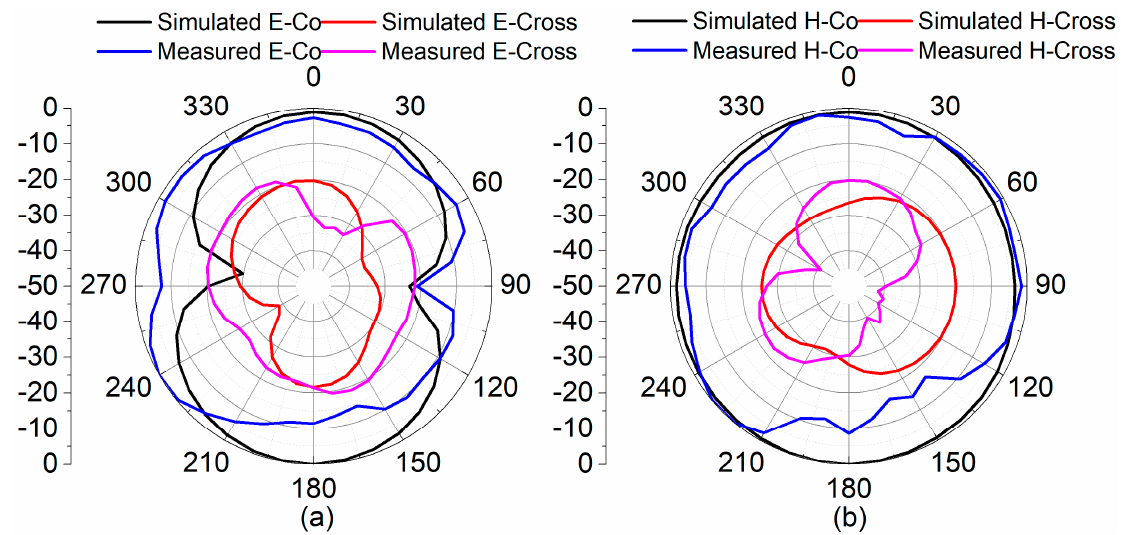
Figure 28. Simulated and measured normalized radiation patterns at 4.75 GHz: ( a ) E-Plane and ( b ) H-Plane.